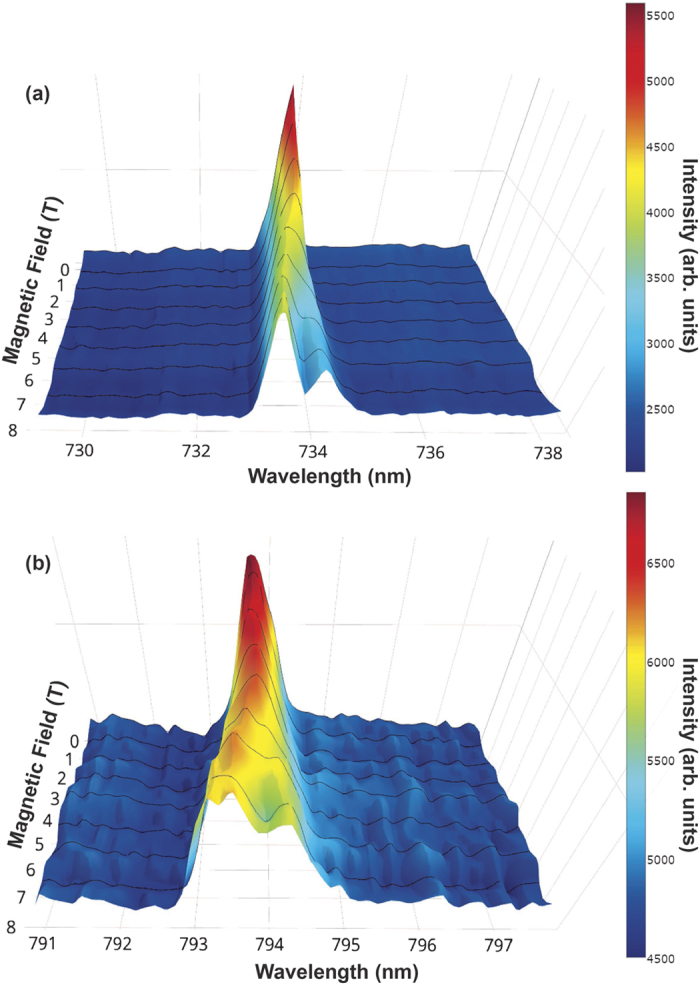
Splitting of the PL peaks in presence of magnetic field (a) LaAlO3 (b) SrTiO3. It can be clearly seen that as we increase the magnetic field from zero to 8T, the peaks split into two sub-peaks.